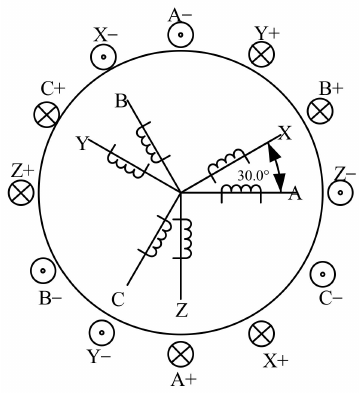
Figure 2. Distribution structure diagram of the six-phase PMSM stator windings. The six-phase PMSM is a six-dimensional system with six independent